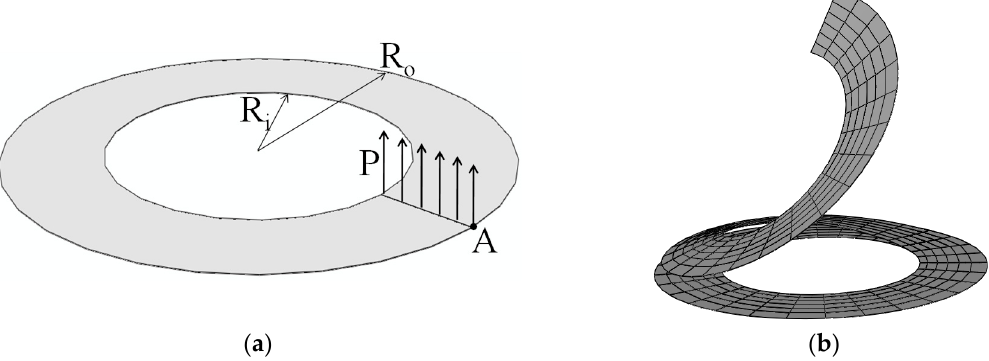
Figure 7. Slit annular plate: ( a ) geometry and ( b ) undeformed and deformed configurations. Materials 2018, 11, x FOR PEER REVIEW